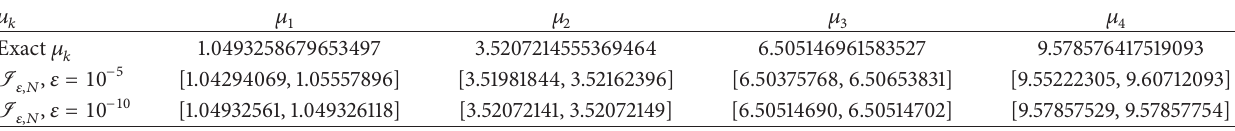
Table 3: For 𝑁 = 15 , 𝑚 = 10 , and 𝜃 = 1/5 , the exact solution 𝜇 𝑘 are all inside the interval [ 𝑏 − , 𝑏 + ] for different values of 𝜀 .